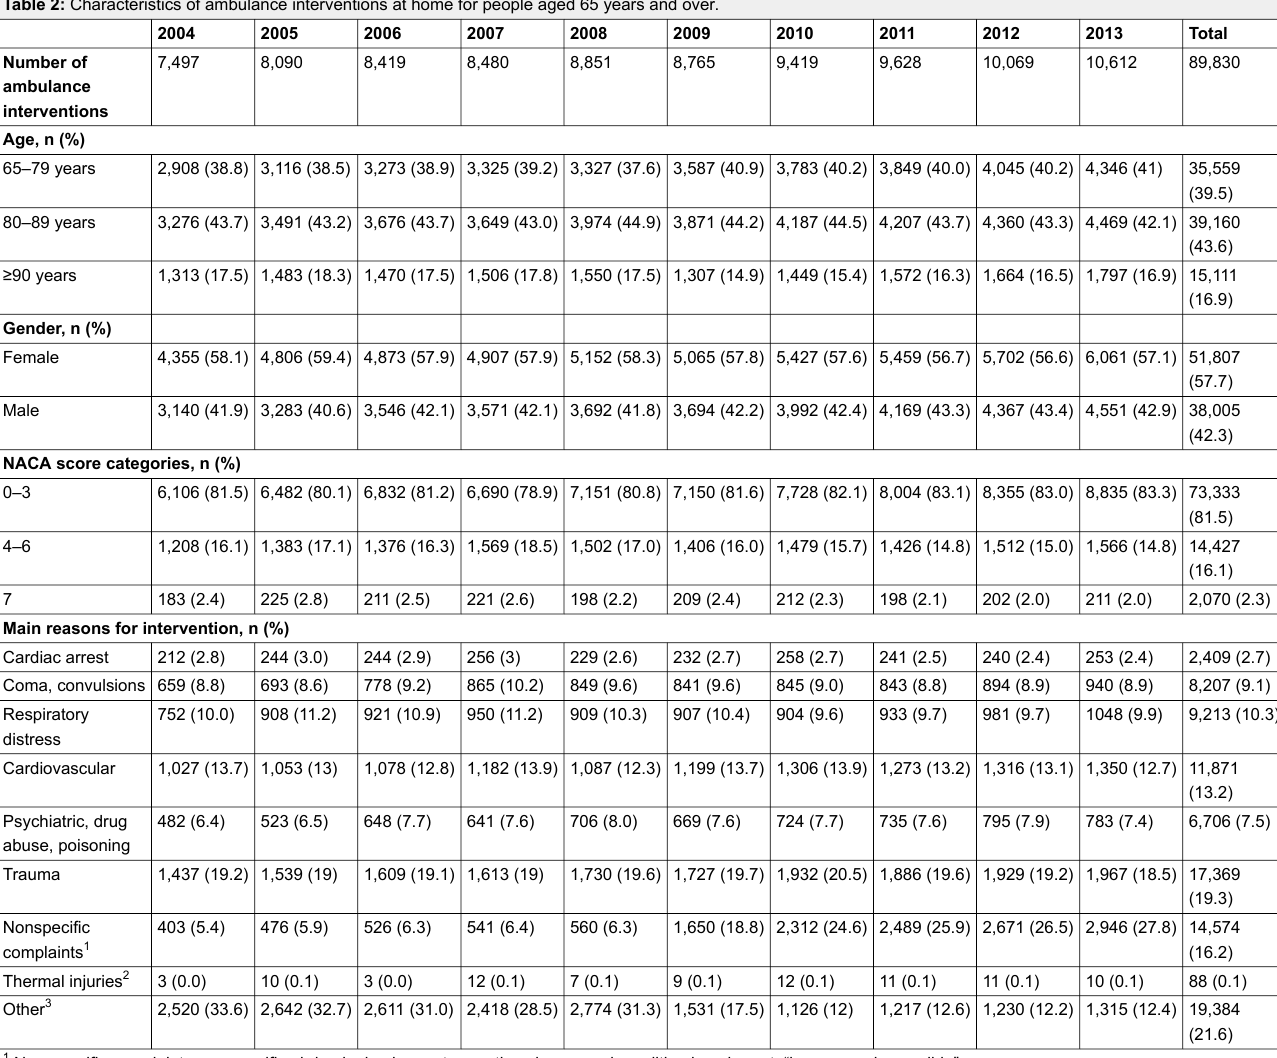
Table 2: Characteristics of ambulance interventions at home for people aged 65 years and